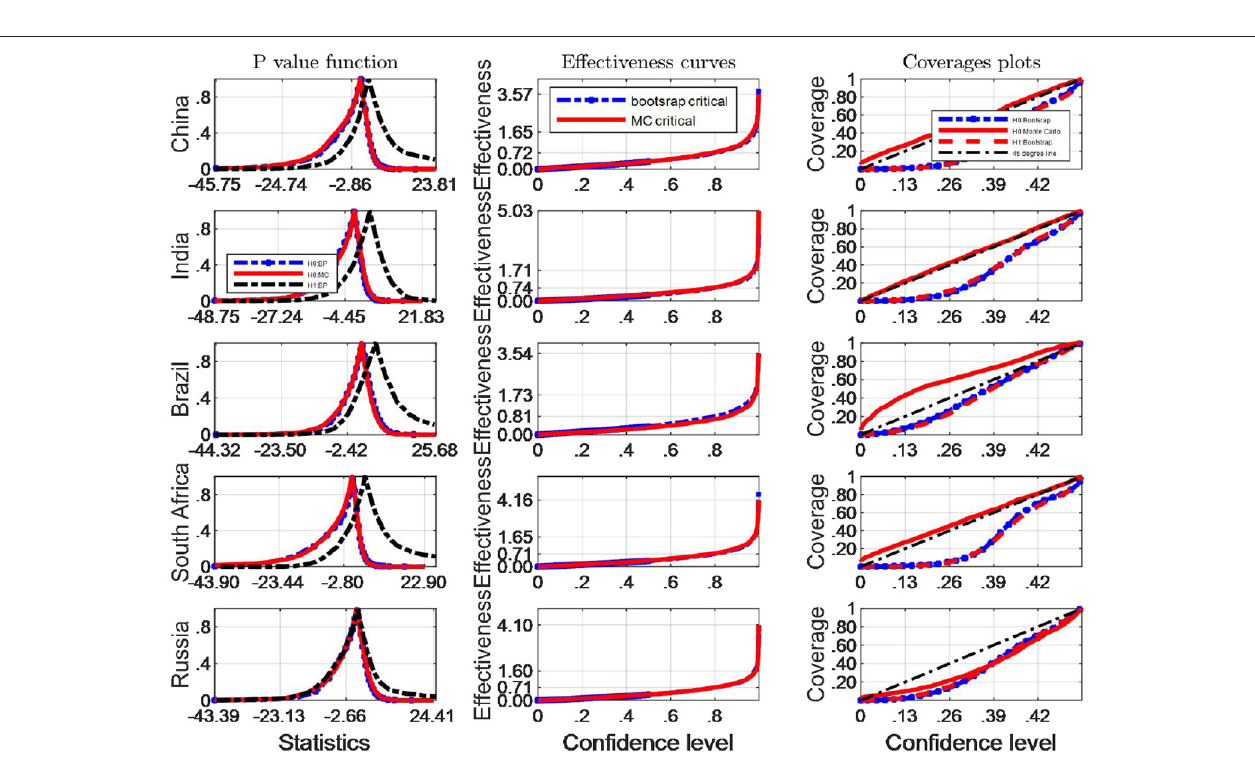
FIGURE 4 | A comparison of confidence intervals of Monte Carlo and counterparts of bootstrap for the Robinson test using BC indicators.